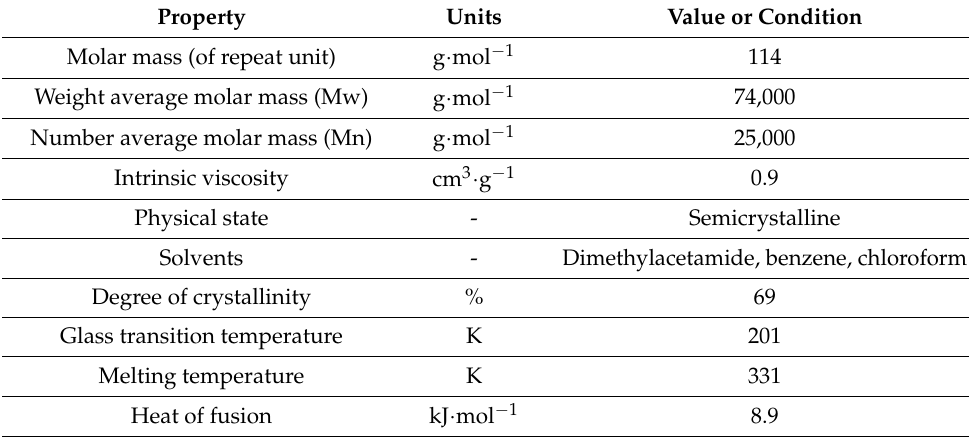
Table 5. PCL relevant properties